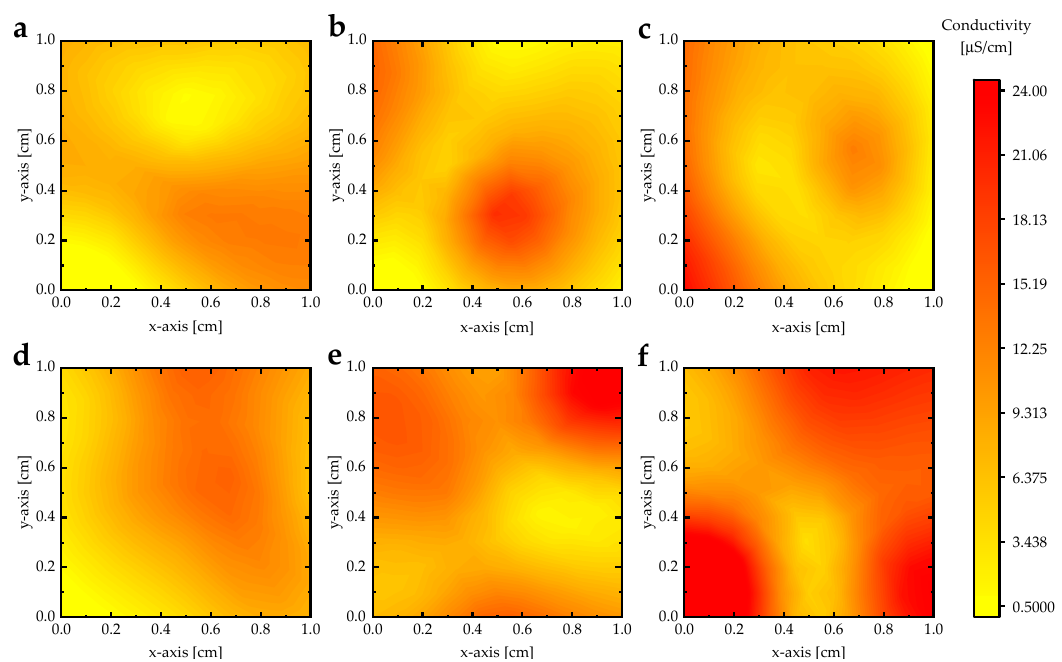
Figure 9. The conductivity maps (1 cm × 1 cm) of (PANI-HCl)/Al(NO 3 ) 3 complex composite films with Al(NO 3 ) 3 concentrations: ( a ) 0 wt.%, ( b ) 2 wt.%, ( c ) 4 wt.%, ( d ) 8 wt.%, ( e ) 16 wt.%, and ( f ) 32 wt.%.